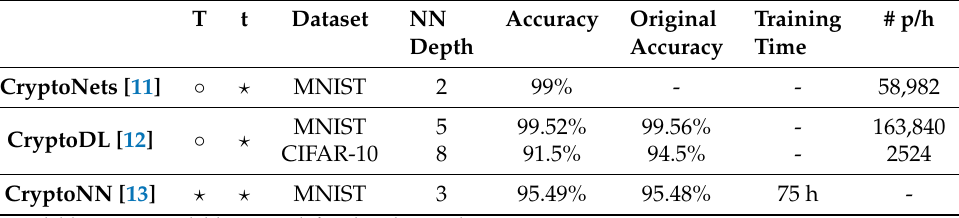
Table 1. Details and properties of the computational methods through the availability of the model training (T) and testing (t) using encrypted data, the dataset used, the depth of the NN (number of convolutional layers in the network), the accuracy of the classification, the accuracy of the orig- inal model(without modification and using simple images), the training time, and the number of predictions per hour that can be processed (#